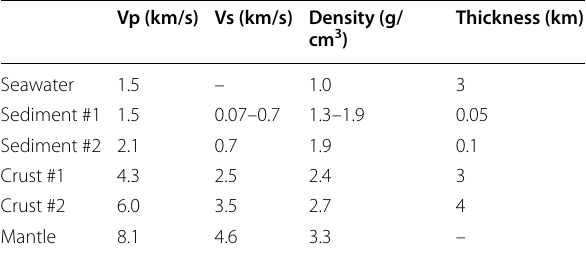
Table 2 Velocity models used in forward